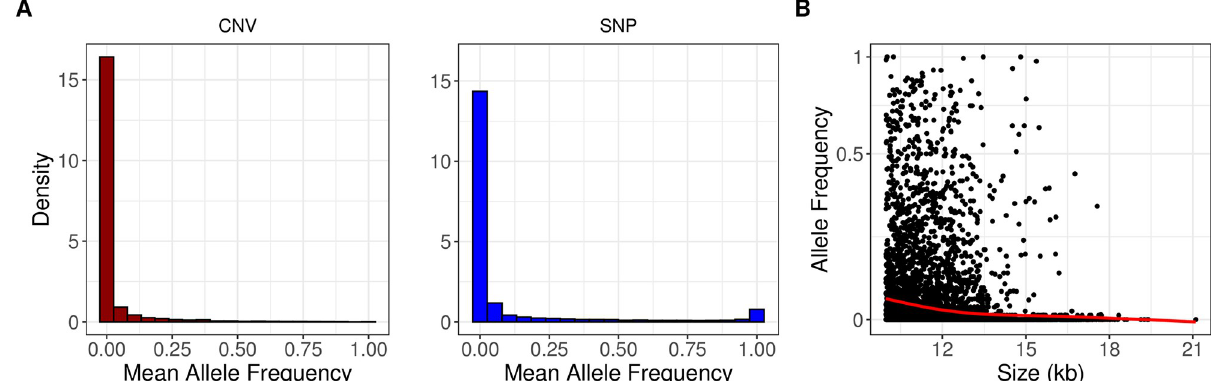
Fig 6. The impact of negative selection on deletions. (A) The site frequency spectra of derived deletion alleles (on the left, n = 3,472) and derived SNP alleles (on the right, n = 57,307). Both plots represent frequency distributions of loci genotyped in all 50 ancient genomes (no missing data). Zero indicates lack of derived alleles. The two distributions are significantly different from each other (Kolmogorov-Smirnov test p < 10 − 15 ). (B) The size distribution (in kbps) of deletion events versus allele frequency. The red line shows the smoothing spline fit and indicates a negative correlation (Spearman correlation r = − 0.33, p < 10 − 16 ). Both axes were log 2 -scaled.